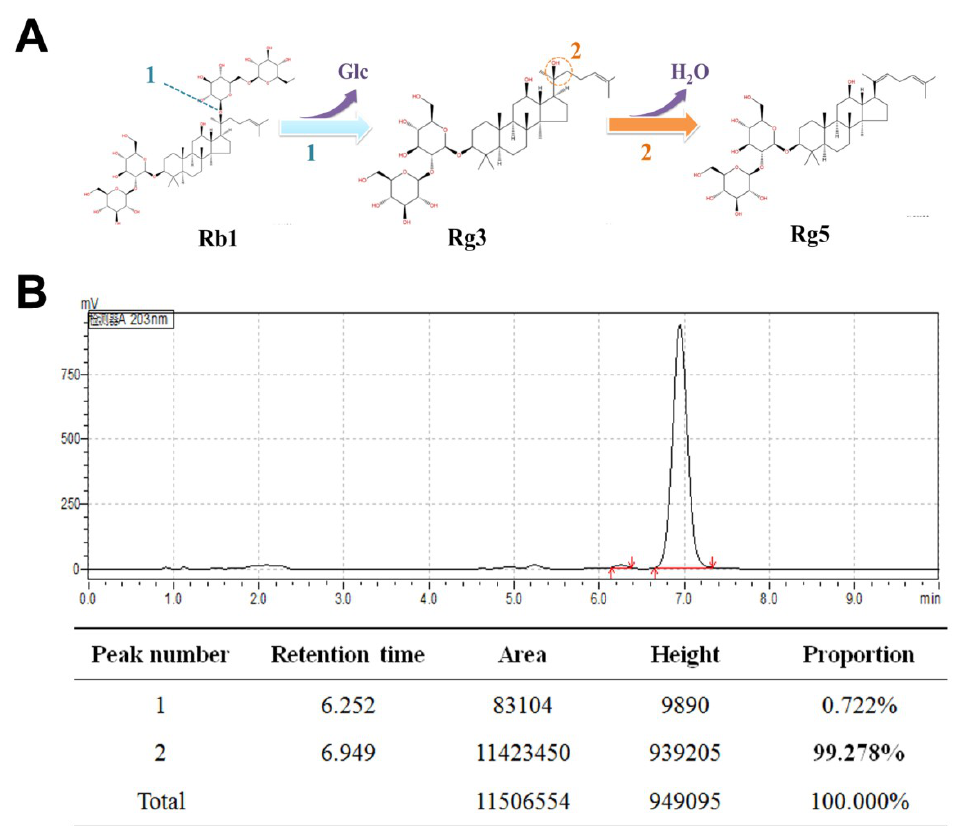
Figure 1. The preparation of ginsenoside Rg5: ( A ) The two steps by which the ginsenoside Rb1 is converted into the ginsenoside Rg5 and ( B ) analytical chromatogram of the obtained ginsenoside Rg5. The bold “99.278%” represents the purity of the separated ginsenoside Rg5.